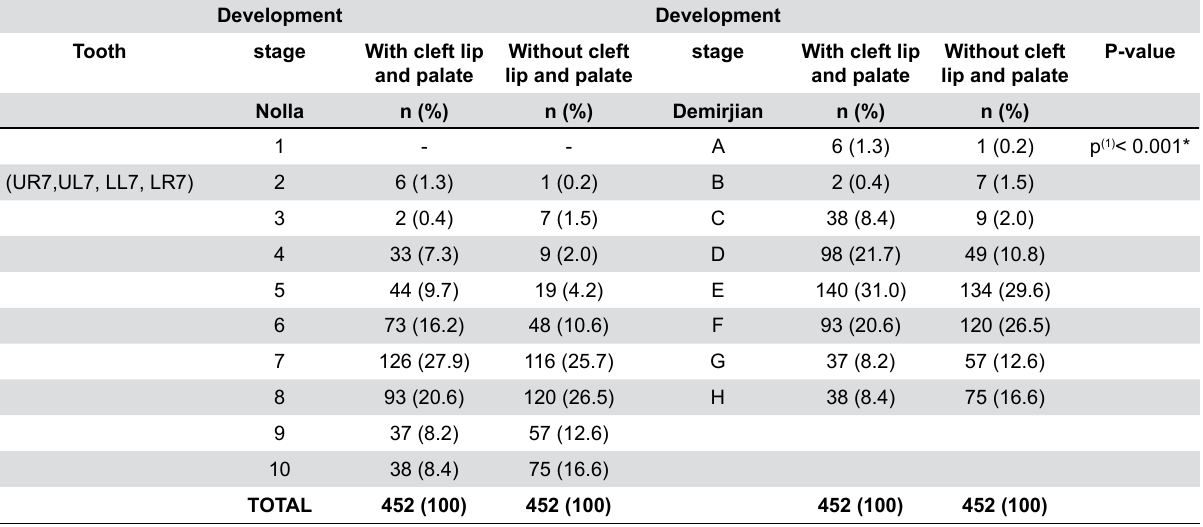
Table 2- Analysis of the development stages of permanent second molars according to Demirjian’s and Nolla’s methods using Wilcoxon’s test for paired